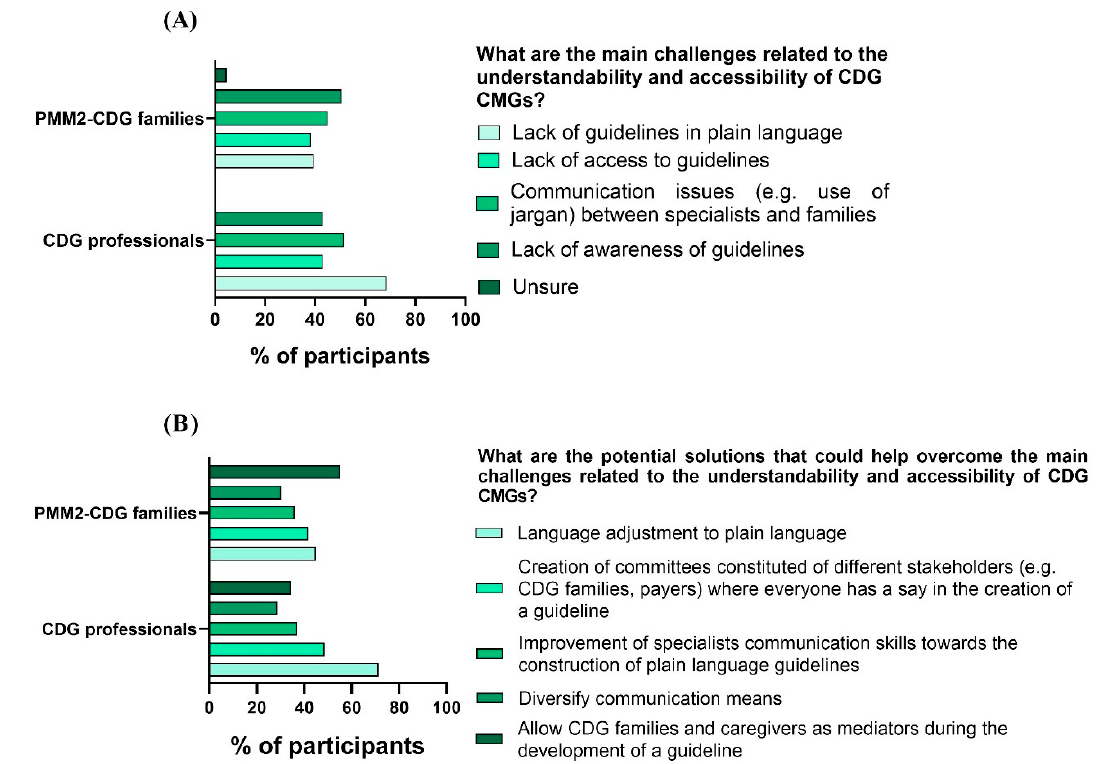
Figure 5. CMG challenges and solutions identified by CDG family and professional participants.